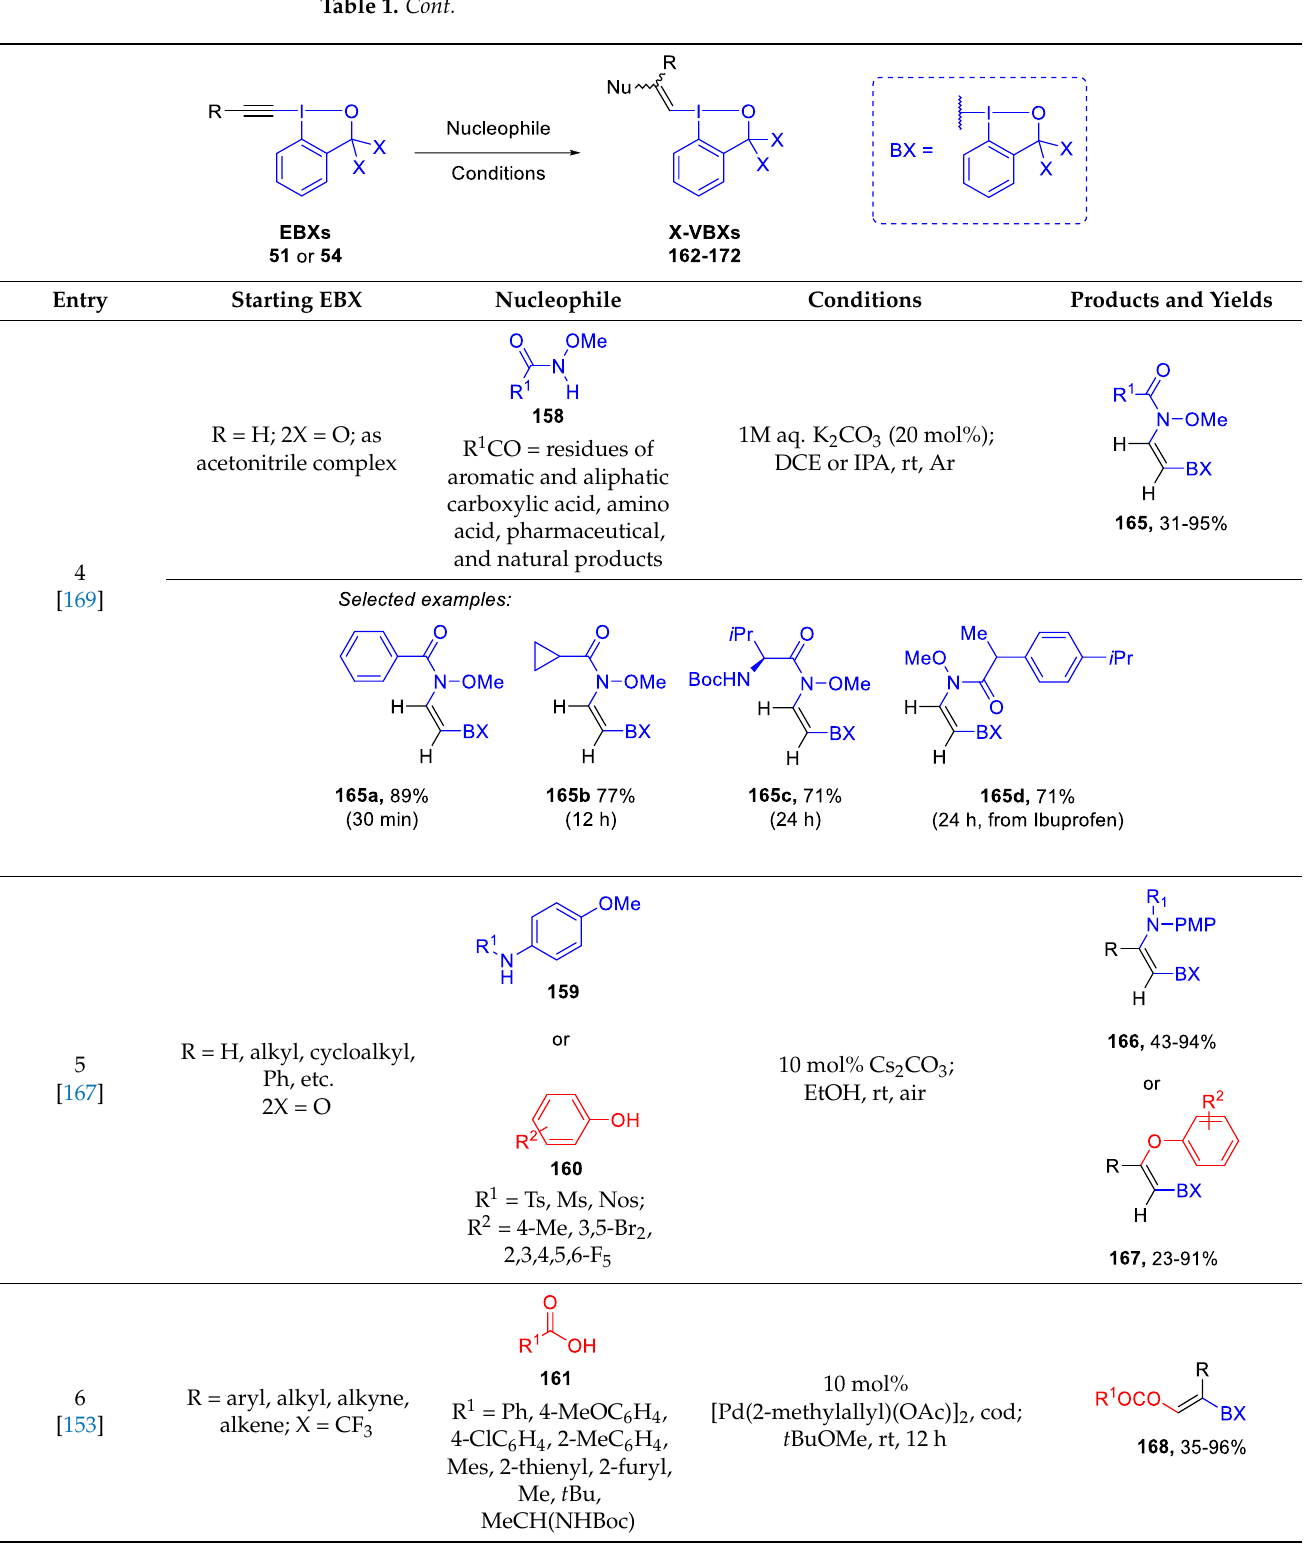
Table 1. Cont. Table 1. Preparation of X-VBX [74,140,143,153,167 –